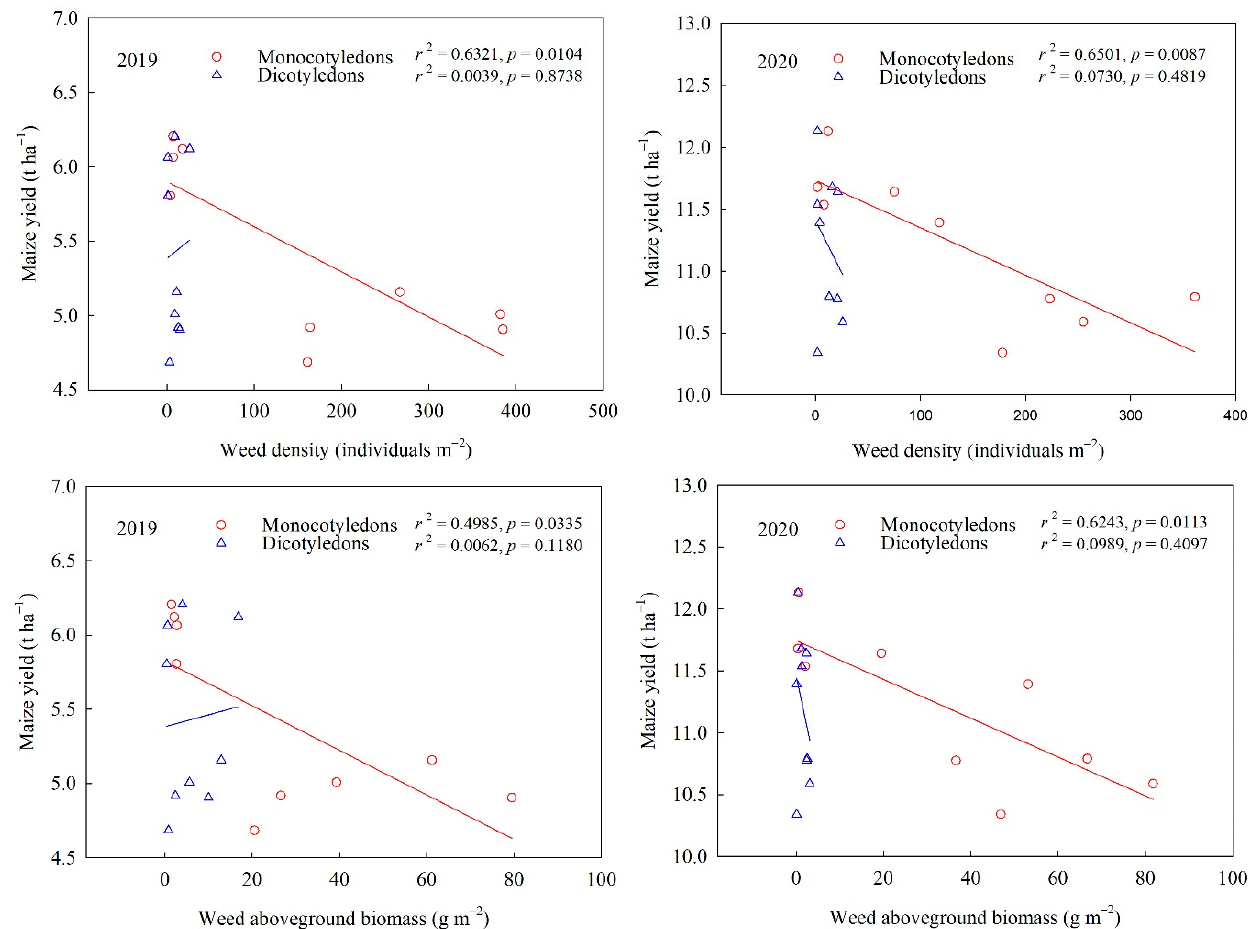
Figure 5. The correlation between maize yield and aboveground dry matter and density of weeds.